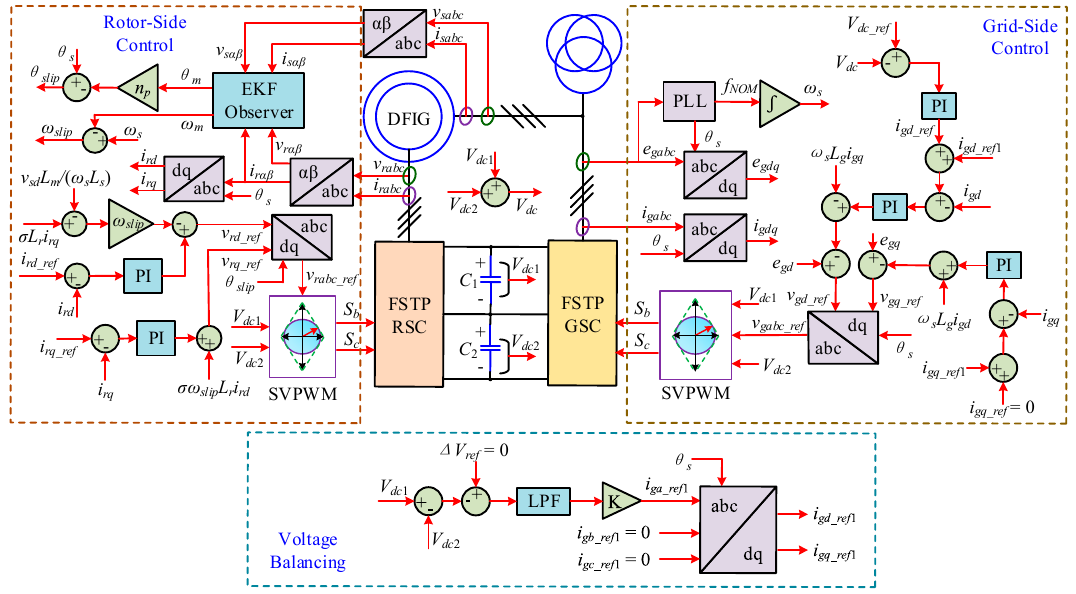
Figure 7. Control block diagram of the FSTP converter-based DFIG-WT by using the EKF estimator. GSC, grid-side converter; LPF, low-pass filter; SVPWM, space vector pulse width modulation.